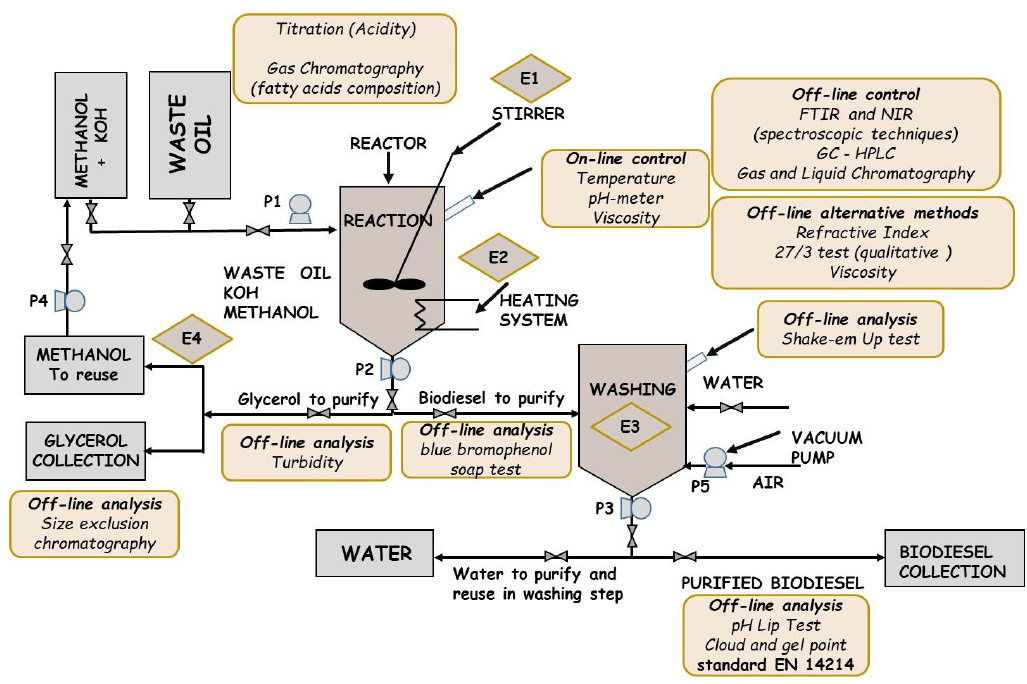
Figure 8. Flow sheet of a small-scale system for biodiesel production including analytical methods.